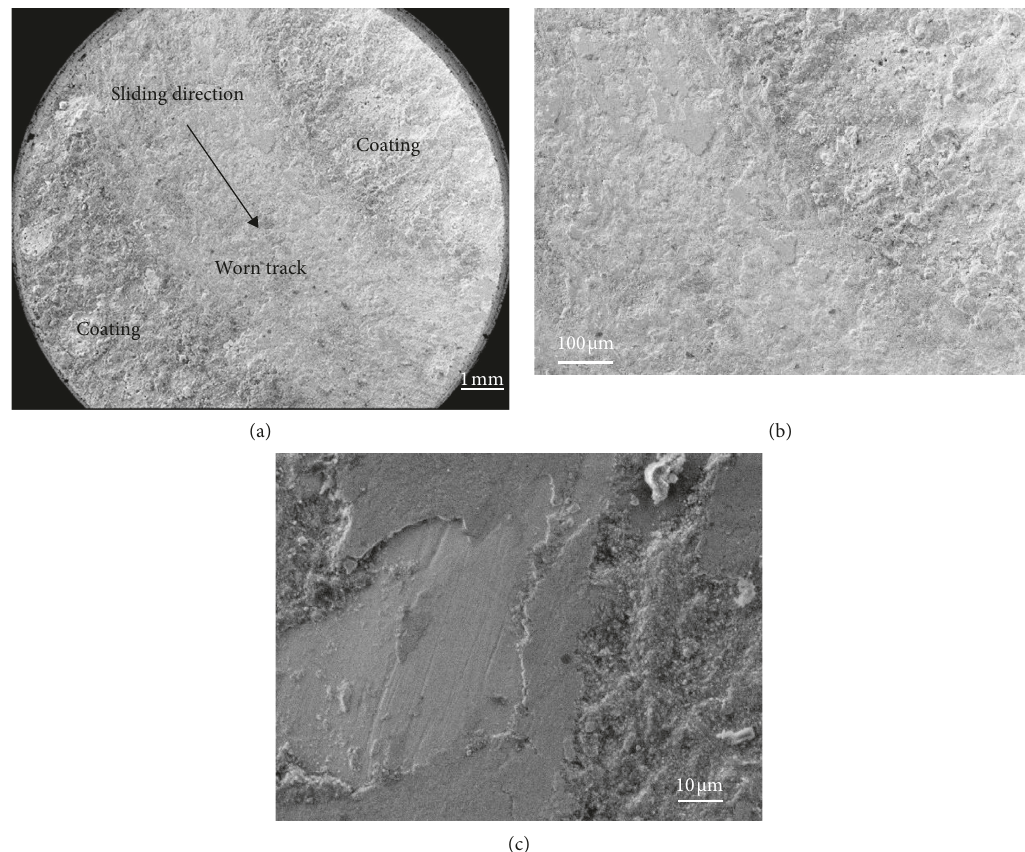
Figure 13: Worn surface (duration of 20 minutes, normal load 5 N, rotation radius 4mm, and rotational speed 400r/min).